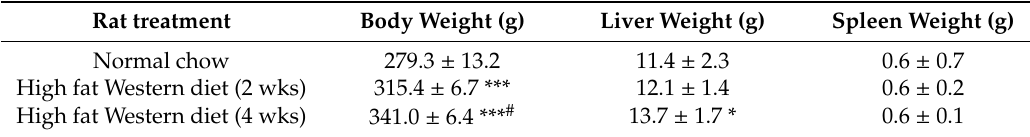
Table 1. Body weight, liver weight and spleen weight of rats receiving normal chow, 2 weeks and 4 weeks high fat Western diet.